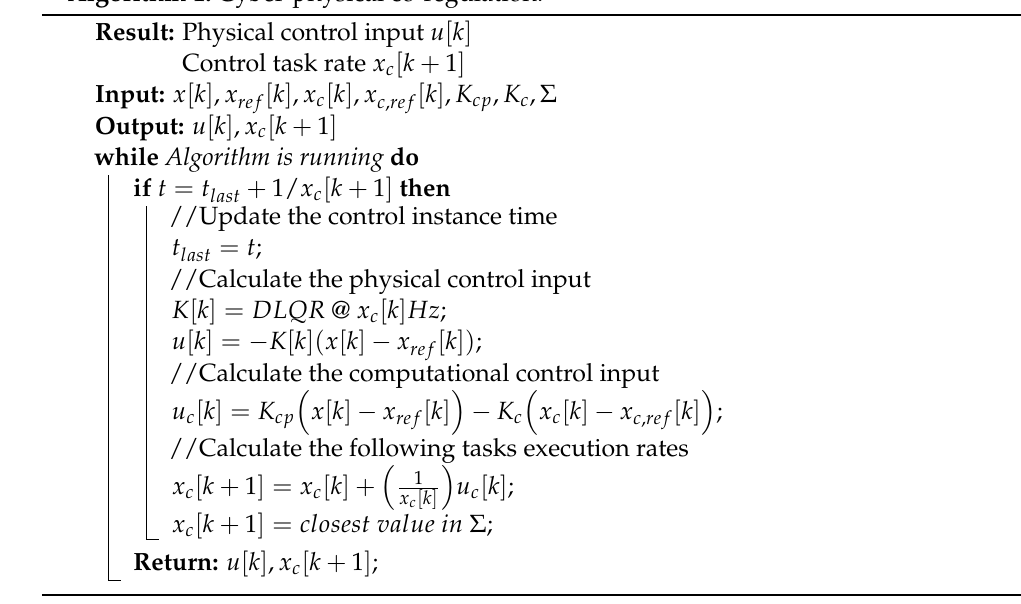
Algorithm 1: Cyber-physical